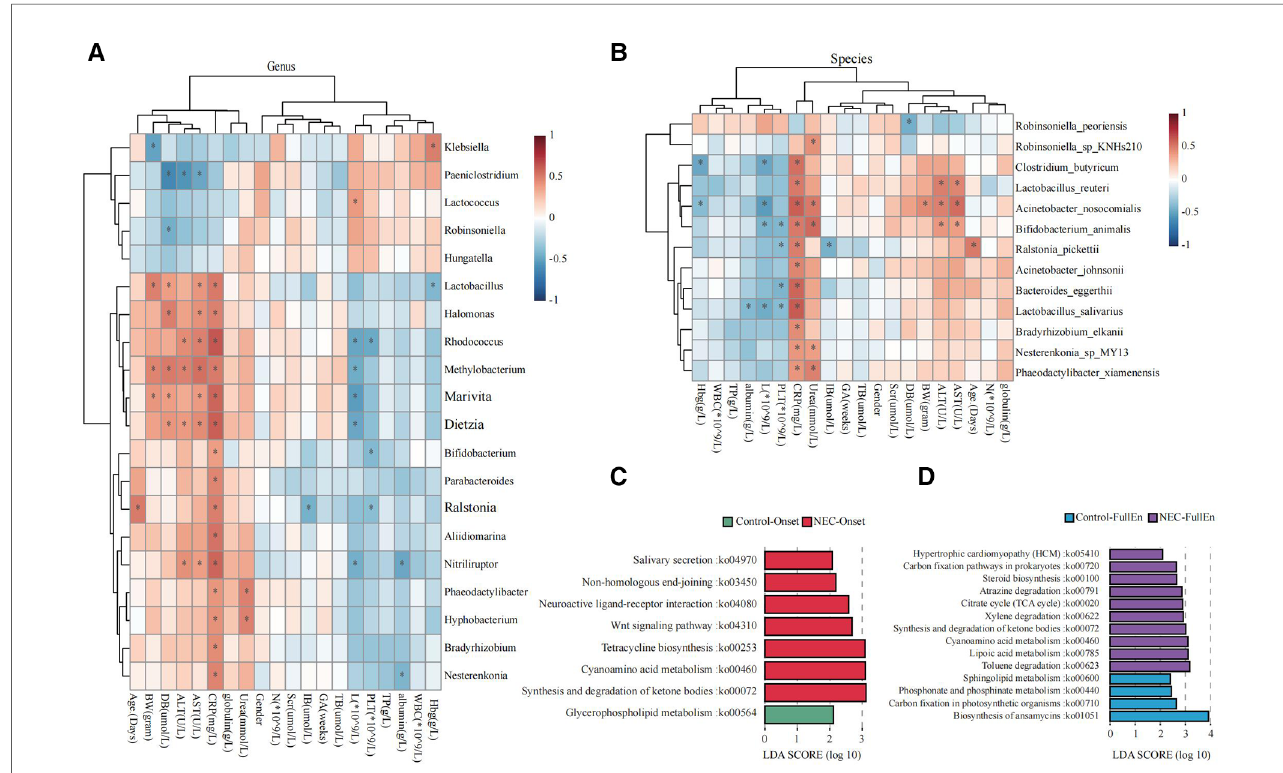
FIGURE 5 Microbial function prediction. ( A ) Correlation heatmap for bacteria at the genus level correlated with clinical characteristics and examinations. ( B ) Correlation heatmap for bacteria at the species level correlated with clinical characteristics and examinations. ( C ) LDA score for microbial pathways when NEC occurred. ( D ) LDA score for microbial pathways when all infants achieved full enteral nutrition. NEC, necrotizing enterocolitis; LDA, linear discriminant